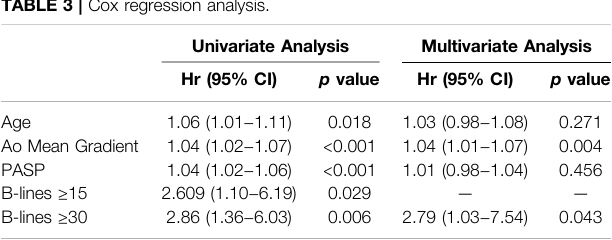
TABLE 3 | Cox regression analysis.